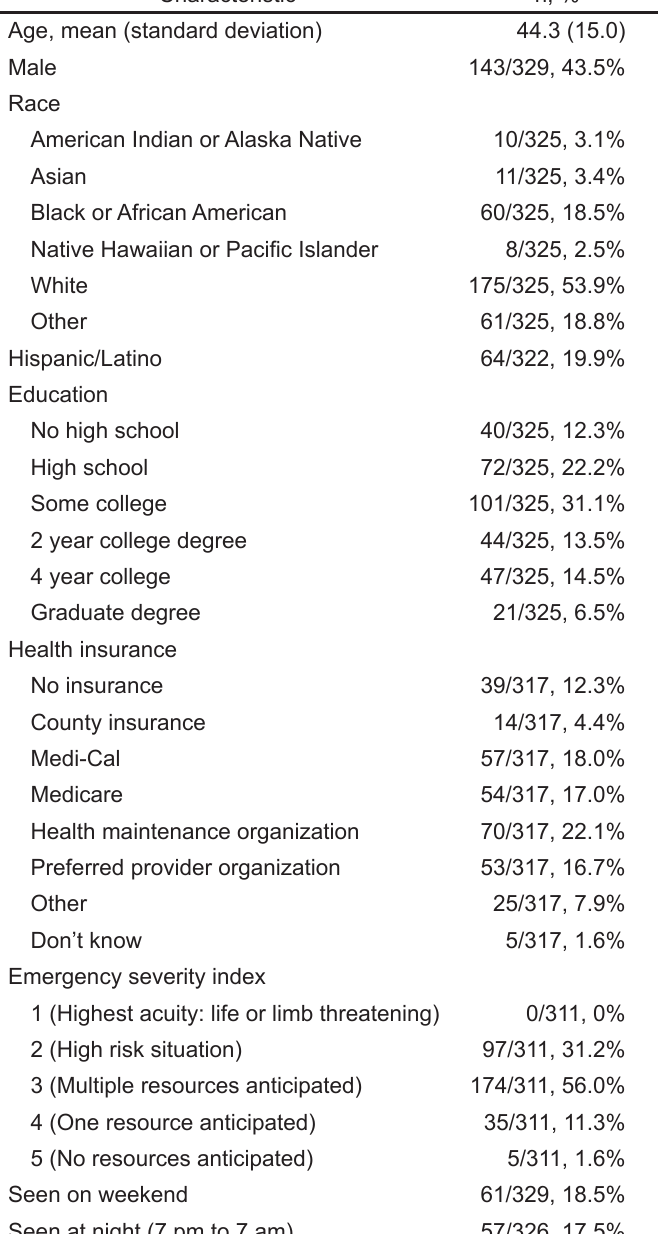
Table 1. Patient characteristics,